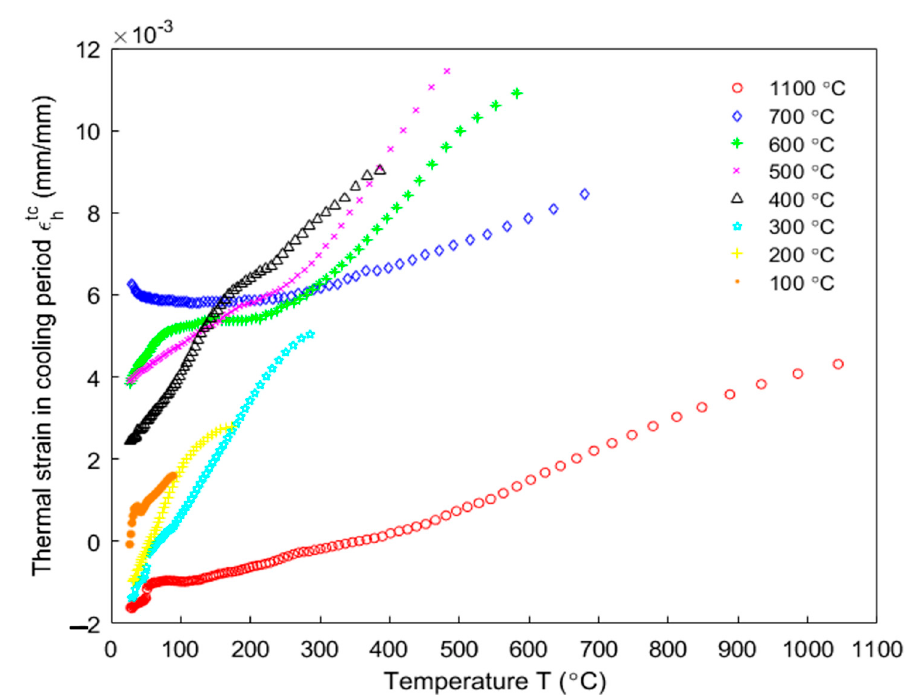
Figure 13. Thermal strain of the sample in the axial direction during the cooling down to the room temperature for different target temperatures ranging from 100 to 1100 °C.